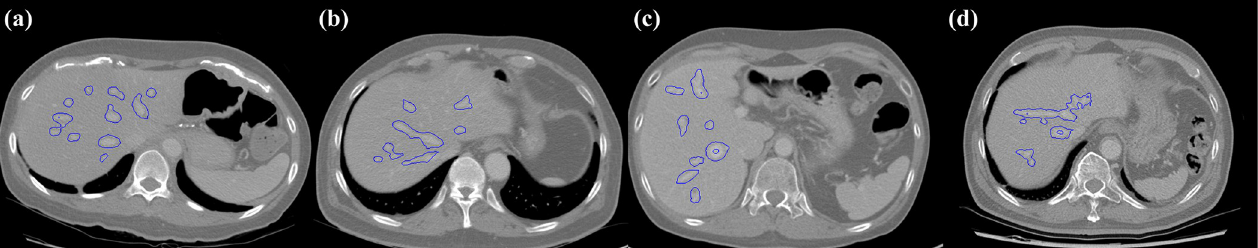
Fig 9. Sample localization results of structural transition region on enhanced hepatic region. The results were displayed for multi-vendor CT images acquired with (a) Scanner 1, (b) Scanner 2, (c) Scanner 3, and (d) Scanner 4, respectively.